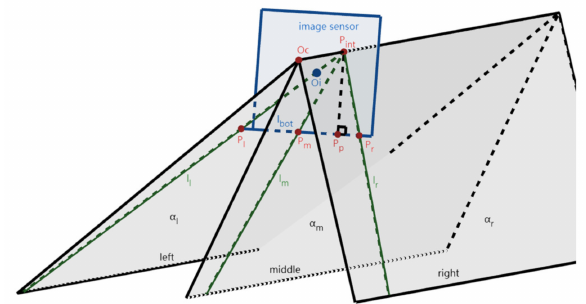
Figure 3. The 3D imaging model of the